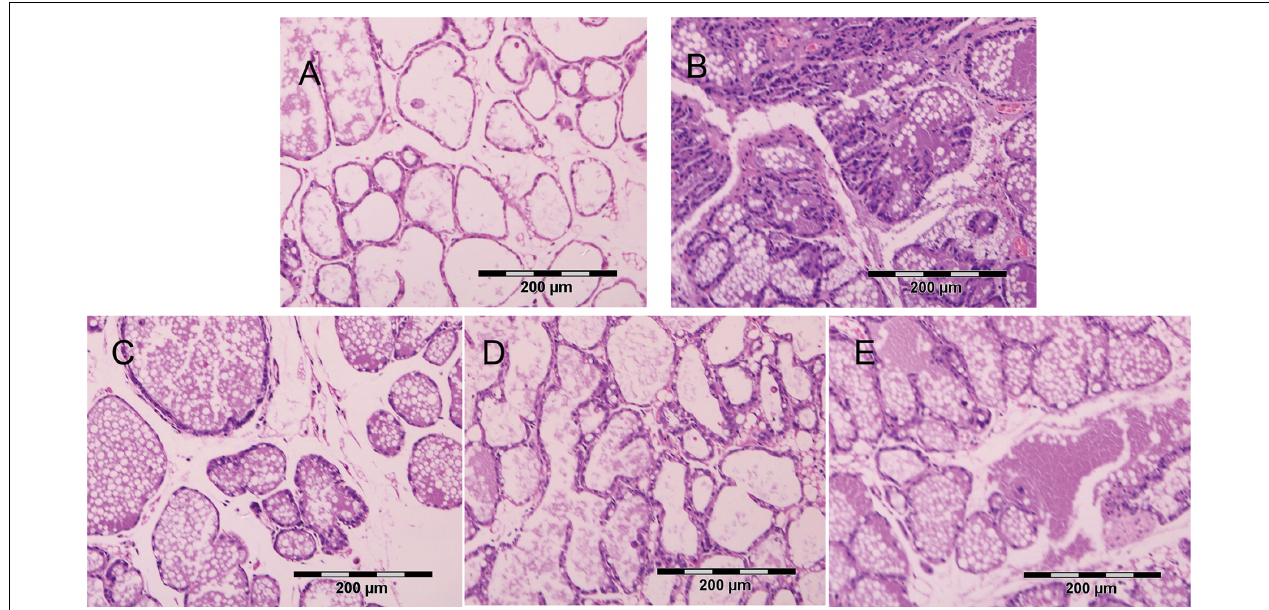
FIGURE 4 | Effects of antimicrobials on mammary tissues (HE, × 100; ruler represents 200 µ m). (A) mammary tissue of the snipped only group (no S. aureus ), (B) S. aureus + PBS treatment, (C) S. aureus + NZ2114 treatment, (D) S. aureus + MP1102 treatment, and (E) S. aureus + tetracycline treatment.